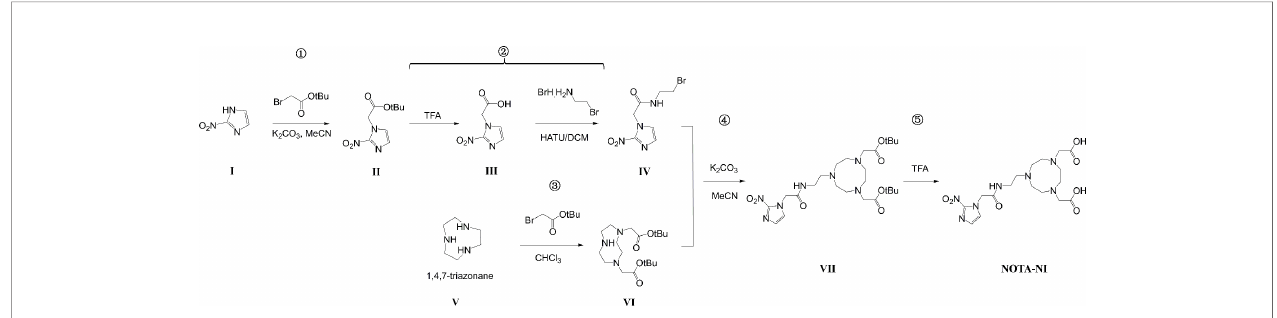
FIGURE 2 | Synthesis pathways of NOTA-NI, a 2-nitroimidazole